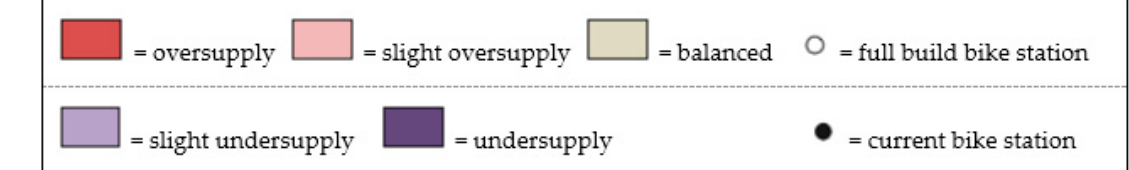
Figure 5. Bike Equity Index and bike share coverage. Table 2. Average Bike Equity Index (BEI)-Density and Level of Tra ffi c Stress (LTS) Score for Individuals with and without Access to Bike